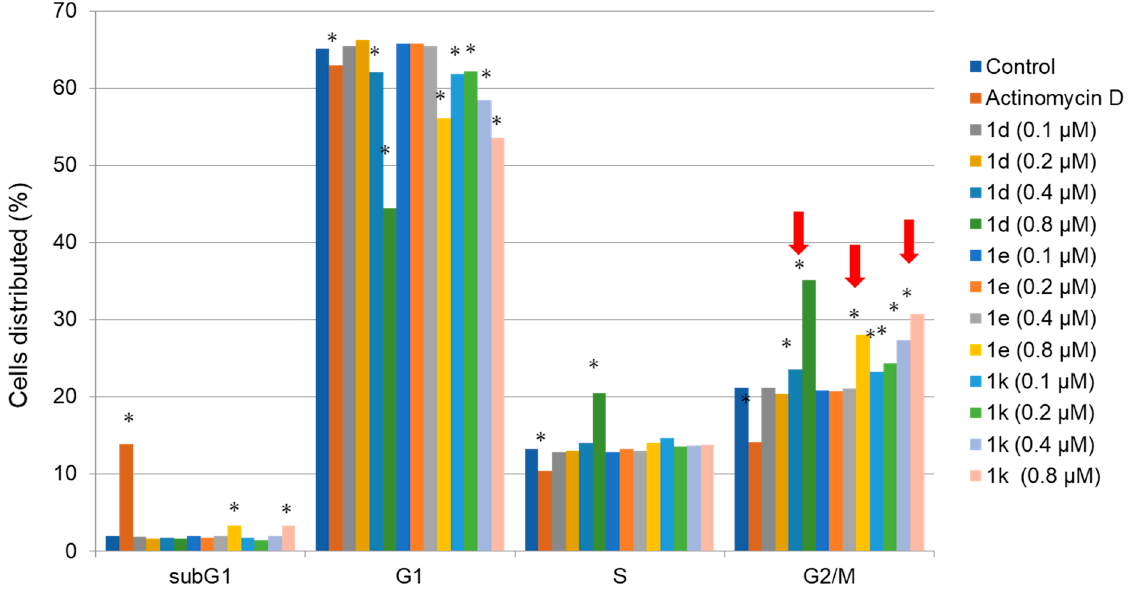
Figure 3. The effect of 1d , e , k on the cell cycle in Ca9-22 cells. Cells were treated without (control) or with 1 µM actinomycin D (AD) or the indicated concentrations of 1d , 1e, and 1k in the presence of the DMSO vehicle (0.1%). Experimental data are presented as the mean ± standard deviation (SD) of triplicate determinations. The significance of values was examined by one-way analysis of variance (ANOVA) and appropriate Dunnett’s post-test. A value of * p < 0.05 was considered to indicate statistically significant differences. The red arrows indicate the highest value of G2/M phase cells in 1d , 1e and 1k .